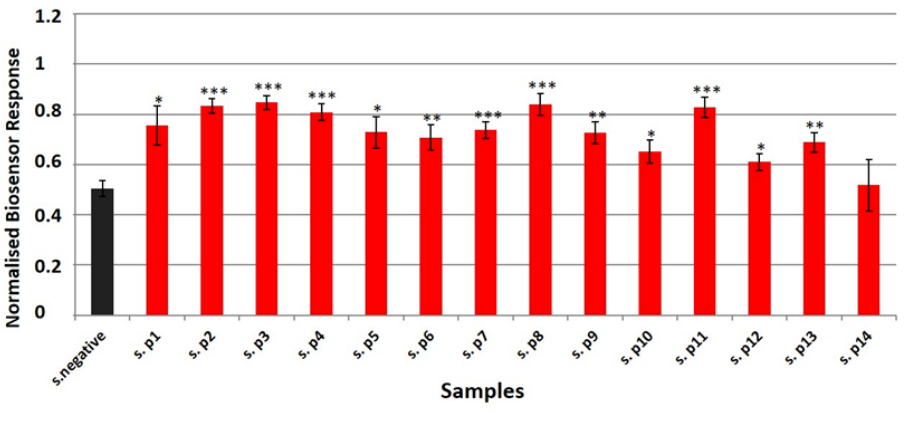
Figure 5. Normalized cell biosensor’s responses to clinical samples from patients ( n = 14) and healthy donors (mean of 10 samples—black column). The membrane engineered cells with the Anti-SARS-CoV-2 Spike S1 antibody were added onto the electrode’s surface in suspension. Results are presented after three minutes of sample–cell interaction. Results are expressed as normalized biosensor responses ([control–sample response]/control). Significant differences (Student’s T -test) between normalized biosensor responses * < 0.05, ** < 0.01, *** < 0.001.